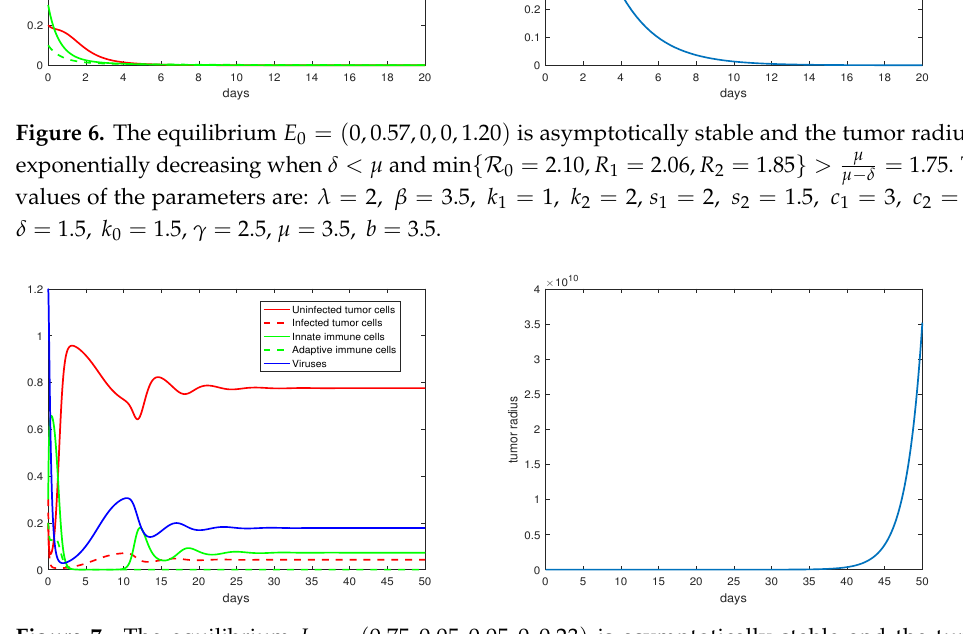
Figure 7. The equilibrium I 1 = ( 0.75,0.05,0.05,0,0.23 ) is asymptotically stable and the tumor radius is exponentially increasing when R 0 = 1.28 > R 1 = 1.12. The values of the parameters are: λ = 2, β = 3.5, k 1 = 1, k 2 = 2, s 1 = 80, s 2 = 20, c 1 = 2, c 2 = 1, δ = 10, k 0 = 1.5, γ = 2.5, µ = 2.5, b = 1.1.